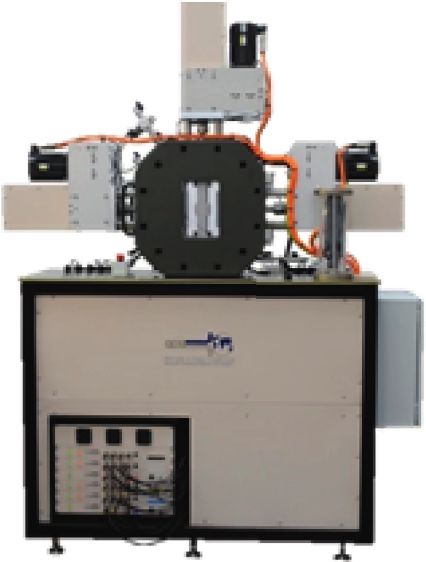
Figure 1: British GDS true-triaxial